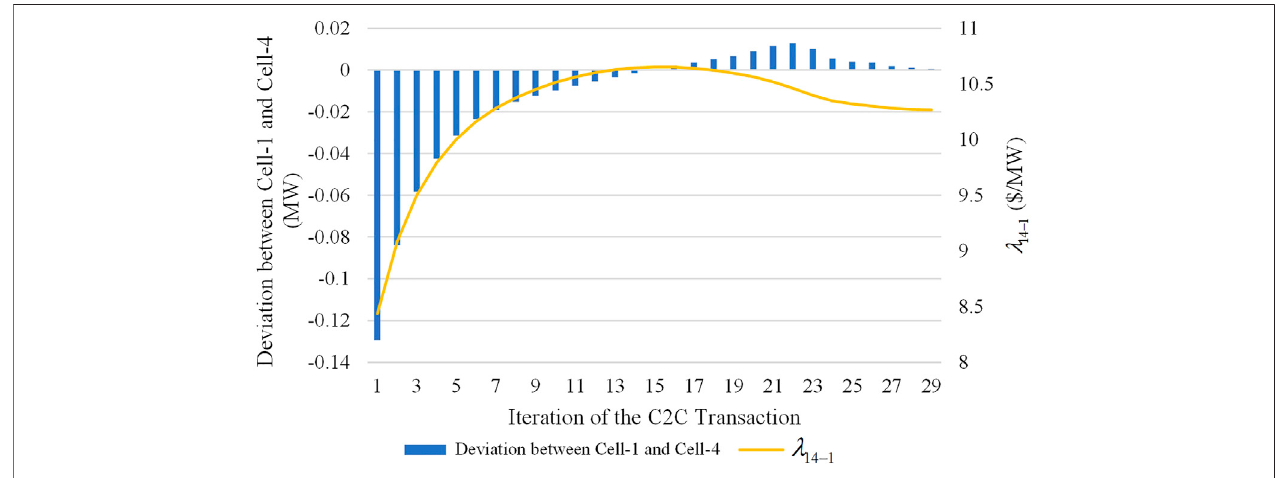
FIGURE 4 | Variation process of the deviation of the transaction plan and λ 14 − 1 .